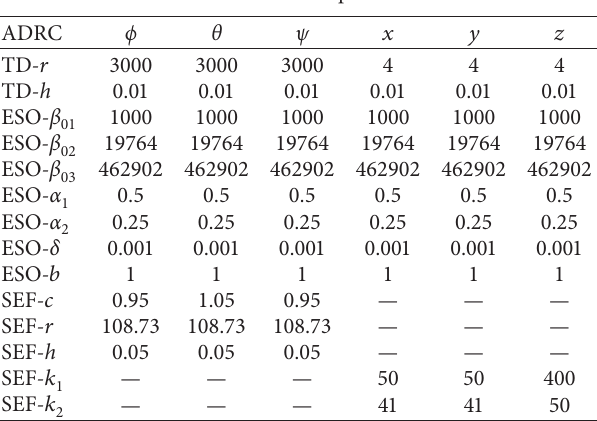
Table 2: Controller